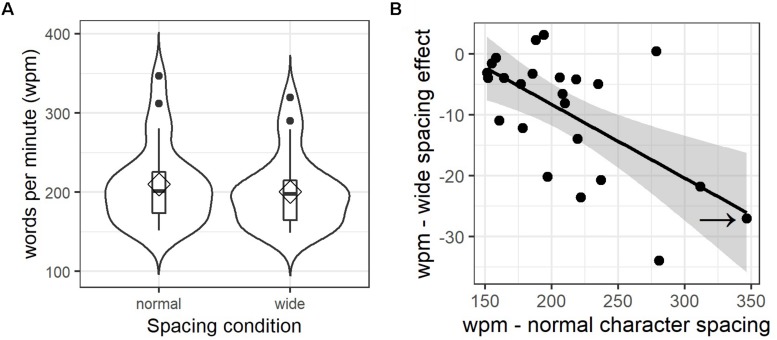
Letter spacing effects on reading rate. (A) Combined violin and box plots of words per minute values, aggregated by participant and spacing condition; diamonds indicate mean values, horizontal bars indicate the median. Filled circles in (A) represent outliers above the third quartile. (B) Scatterplot illustrating the correlation of mean words per minute (wpm) values under normal spacing (x-axis) with individual differences in the letter spacing effect (wide minus normal condition; y-axis). Error corridors represent the pointwise 95% confidence interval on the fitted values of the linear regression (black line). The arrow points at the example participant described in the text.